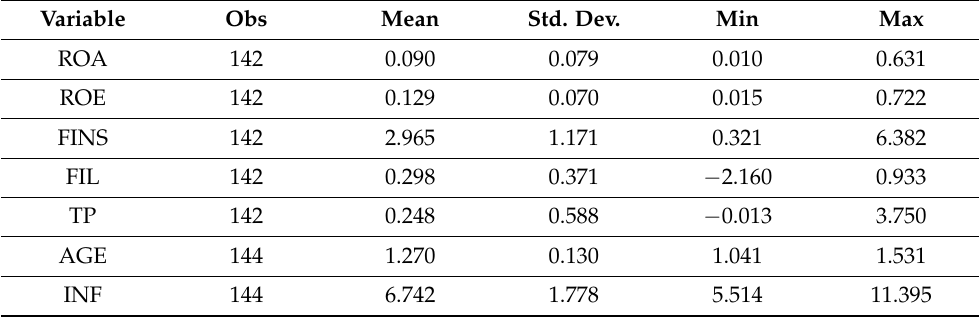
Table 3. Summary